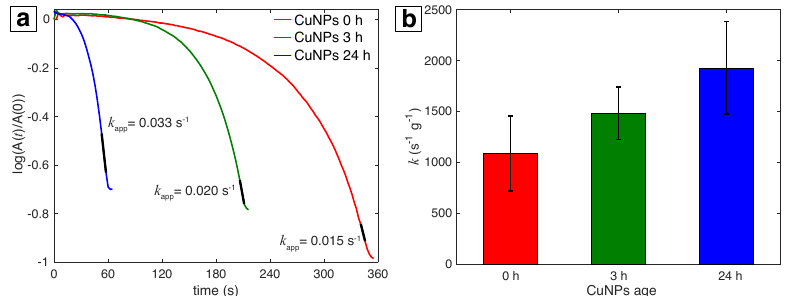
Figure 5. ( a ) Time dependence of the absorbance of p -nitrophenolate ions at 400 nm for a representa- tive sample at 0 h, 3 h, and 24 h; black portion of line is where k app (s − 1 ) is extracted. ( b ) Specific rate constants (s − 1 g − 1 ) with error bars generated over three runs for 0 h, 3 h, 24 h samples each.